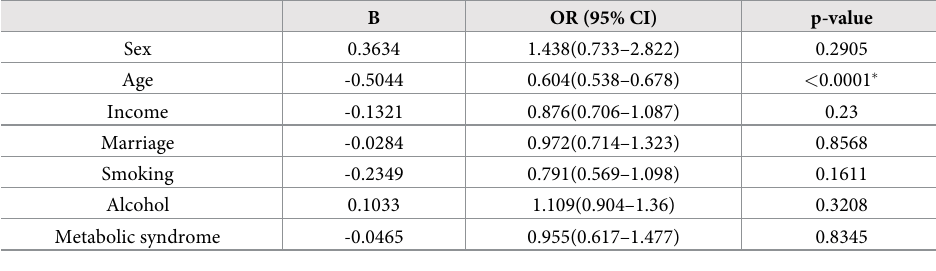
Table 3. Multiple regression analysis for variables affecting hearing impairment in noise-exposed group.